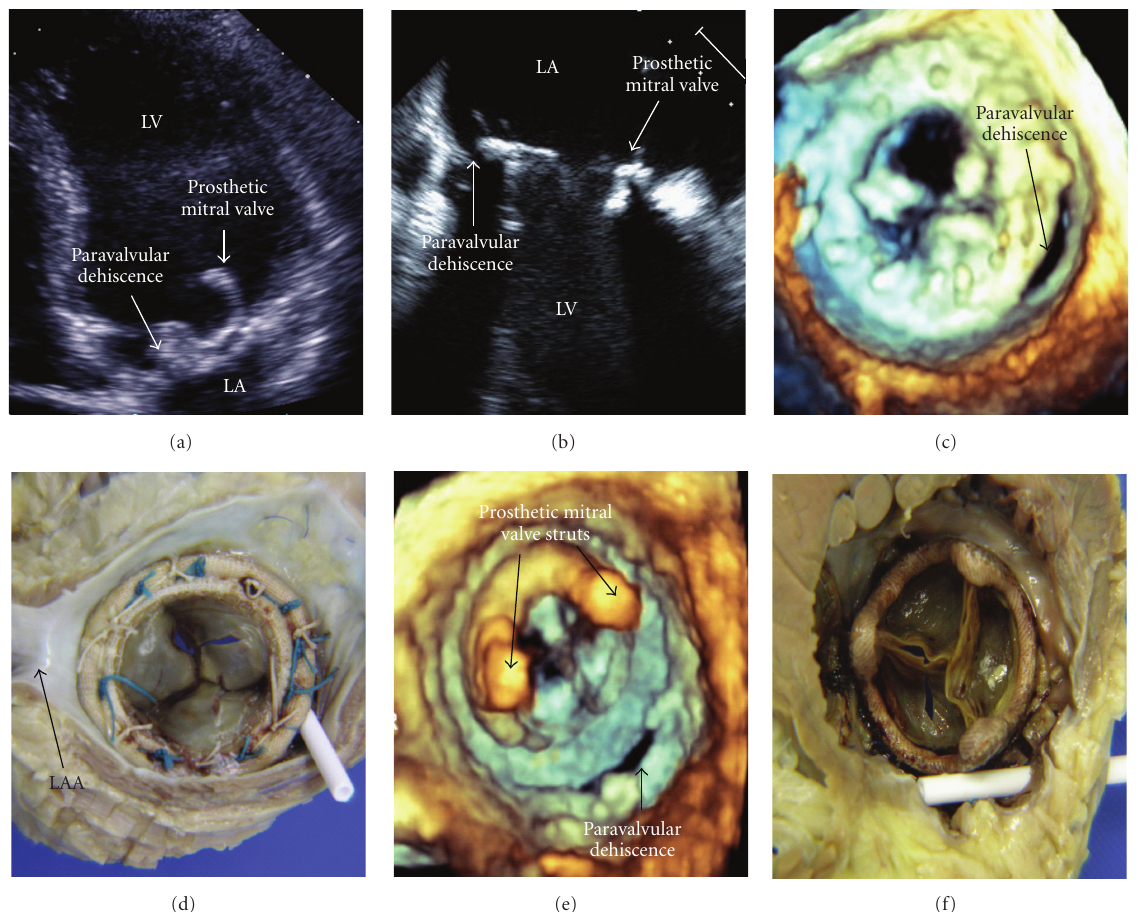
Figure 1: Comparison of prosthetic mitral valve dehiscence by di ff ering echo modalities and direct comparison to postmortem specimens. (a) demonstrates the prosthetic mitral valve paravalvular dehiscence using 2D TTE (Online Video 1). The 3mm defect is shown in more detail using 2D TOE (b) (Online Videos 2 and 3). Real-time 3D TOE clearly shows the crescent-shaped posteromedial paravalvular dehiscence from the atrial aspect (c) (Online Video 4) compared to the postmortem specimen (d) and the ventricular aspects (e) and (f) (Online Video 5). Also, note the two 4mm echo densities on the atrial surface of the prosthetic mitral valve on the 2D TOE (b) (Online Video 2) which were subsequently found to be sutures on the postmortem specimen (d). The 3D real-time colour Doppler TOE can be seen in Online Video 6. 2D: 2-Dimensional; TTE: transthoracic echocardiography; TOE: transoesophageal echocardiography; 3D: